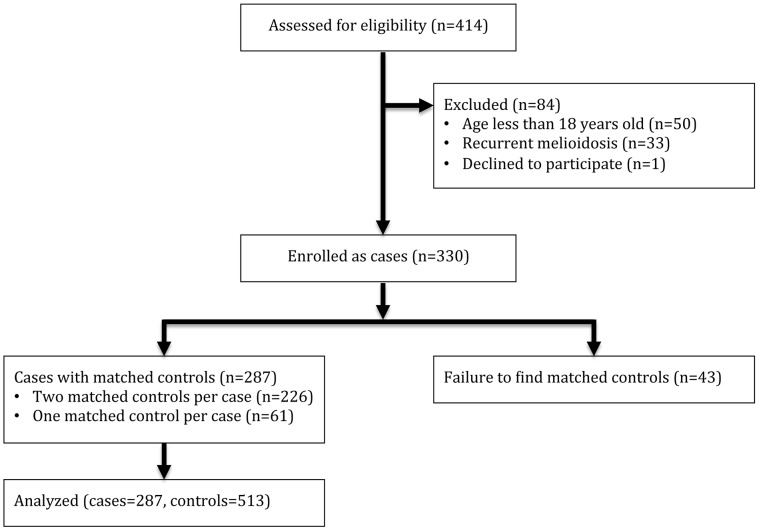
Study flow diagram.